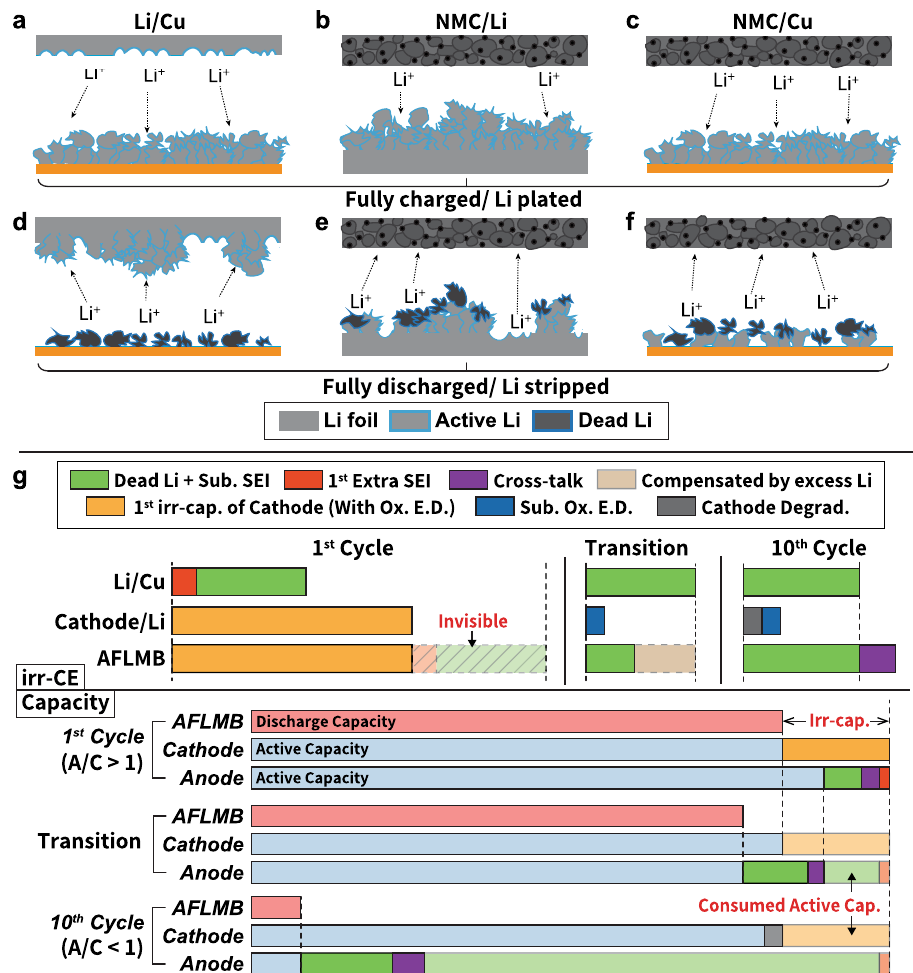
Fig. 3 Integrated protocol and scheme of different cell con fi gurations at fully charged and discharged states. Scheme of a Li/Cu, b NMC/Li, and c NMC/Cu cells at fully charged/ Li pated sate in the fi rst cycle, respectively. Scheme of d Li/Cu, e NMC/Li, and f NMC/Cu cells at fully discharge/Li- stripped state in the fi rst cycle, respectively. g Proposed integrated protocol to unravel the origins of irreversible CE in AFLMB by Li/Cu and cathode/Li cells. The blue shell on Li represents the SEI layer. Sub. SEI stands for the subsequent SEI formation, Ox. E.D. for oxidative electrolyte decomposition, and cathode degrad. for cathode degradation,